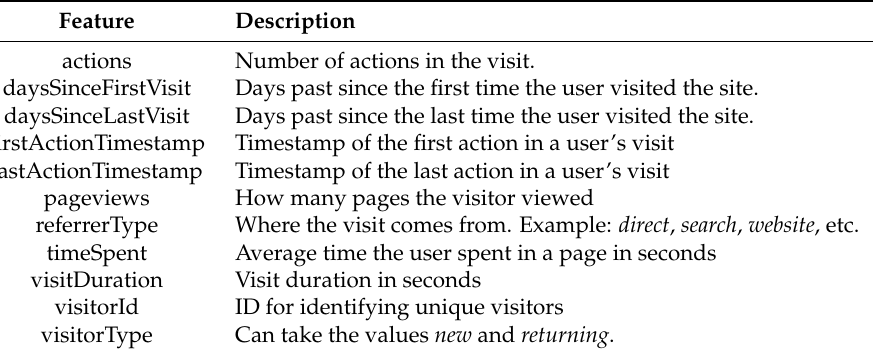
Table 3. Features from